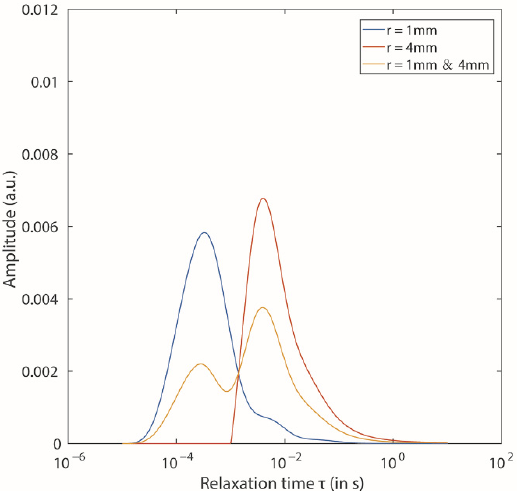
Figure 6. Relaxation time distributions for the seafloor disseminated metal sulfide models with sulfide particles with various grain radii. The blue line denotes models containing fine sulfide particles with a grain radius of 1 mm; the red line denotes models containing coarse sulfide particles with a grain radius of 4 mm; the yellow line denotes models containing both fine and coarse sulfide particles in equal proportions.